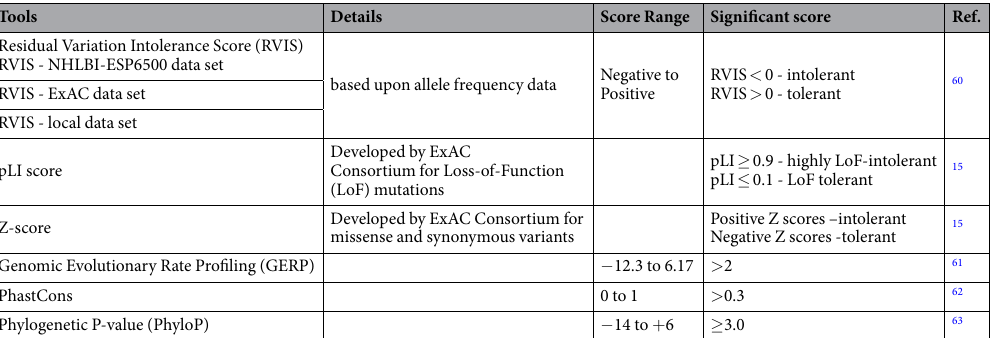
Table 1. Summary of intolerance scores and conservational